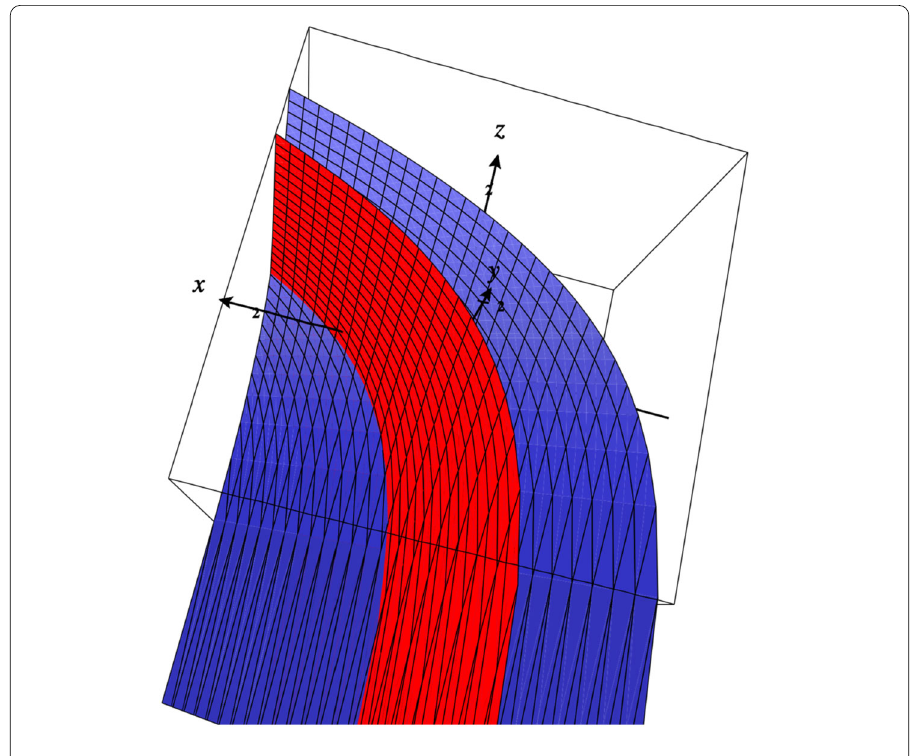
([ Se ] γ ,[ Tx ] β 1 2 4